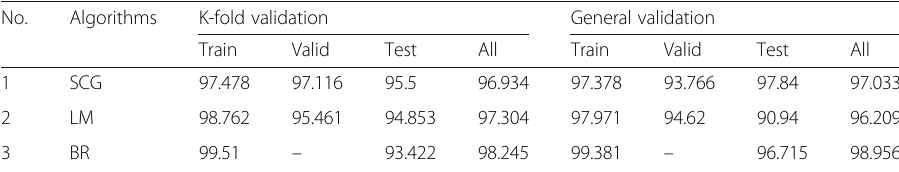
Table 2 Accuracy (in %) comparison between K-fold and General validation for 15-min tick data No.